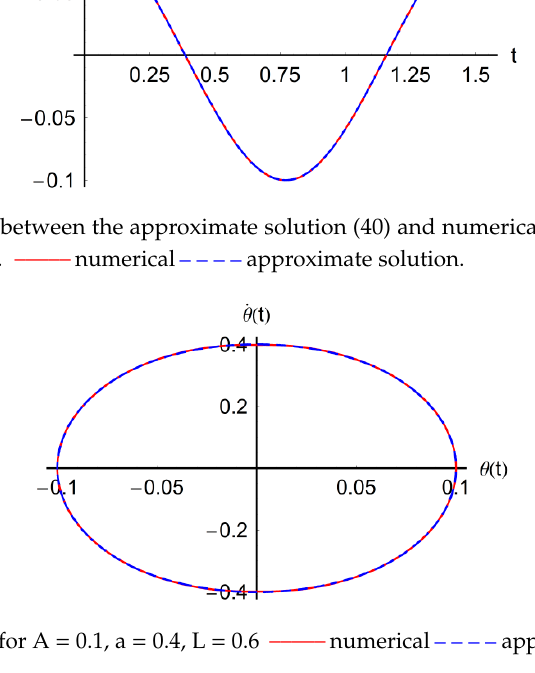
Figure 20. Comparison between the approximate solution (50) and numerical integration results for Figure 21. Phase plane for A = 0.4, L = 0.6.